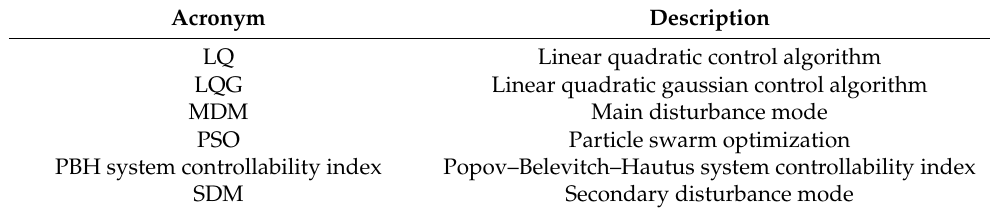
Table A1. List of acronyms used in the article.